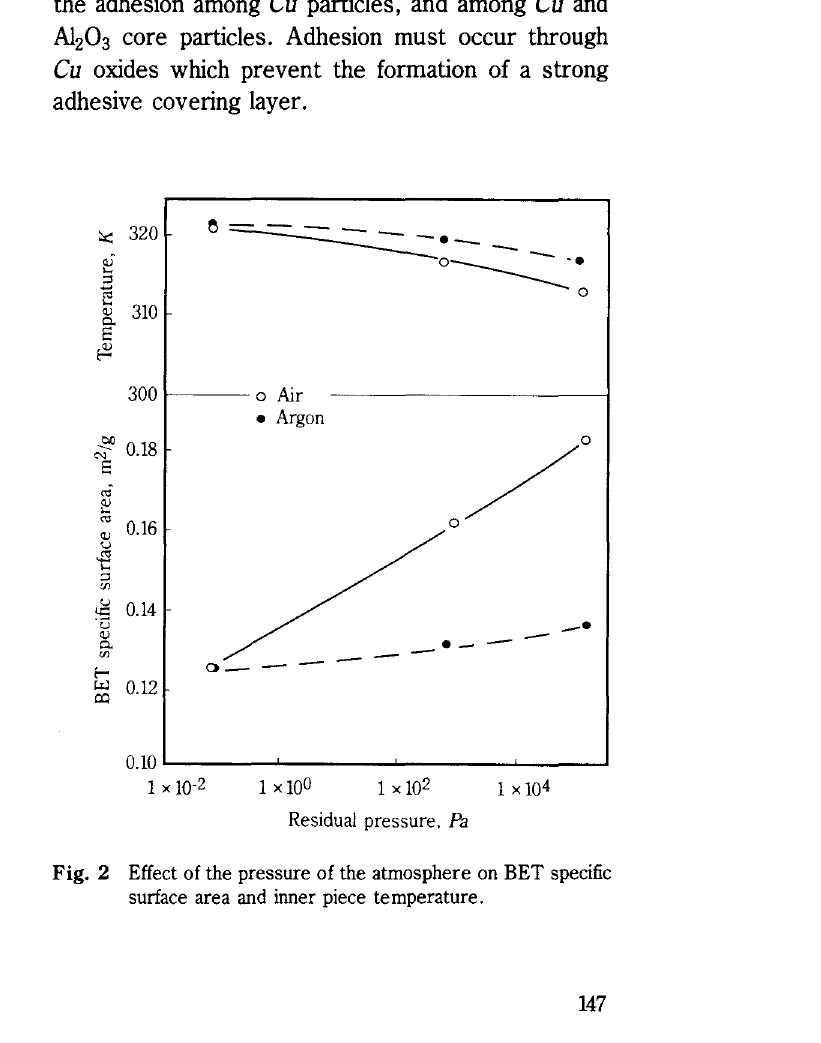
Fig. 2 Effect of the pressure of the atmosphere on BET specific surface area and inner piece